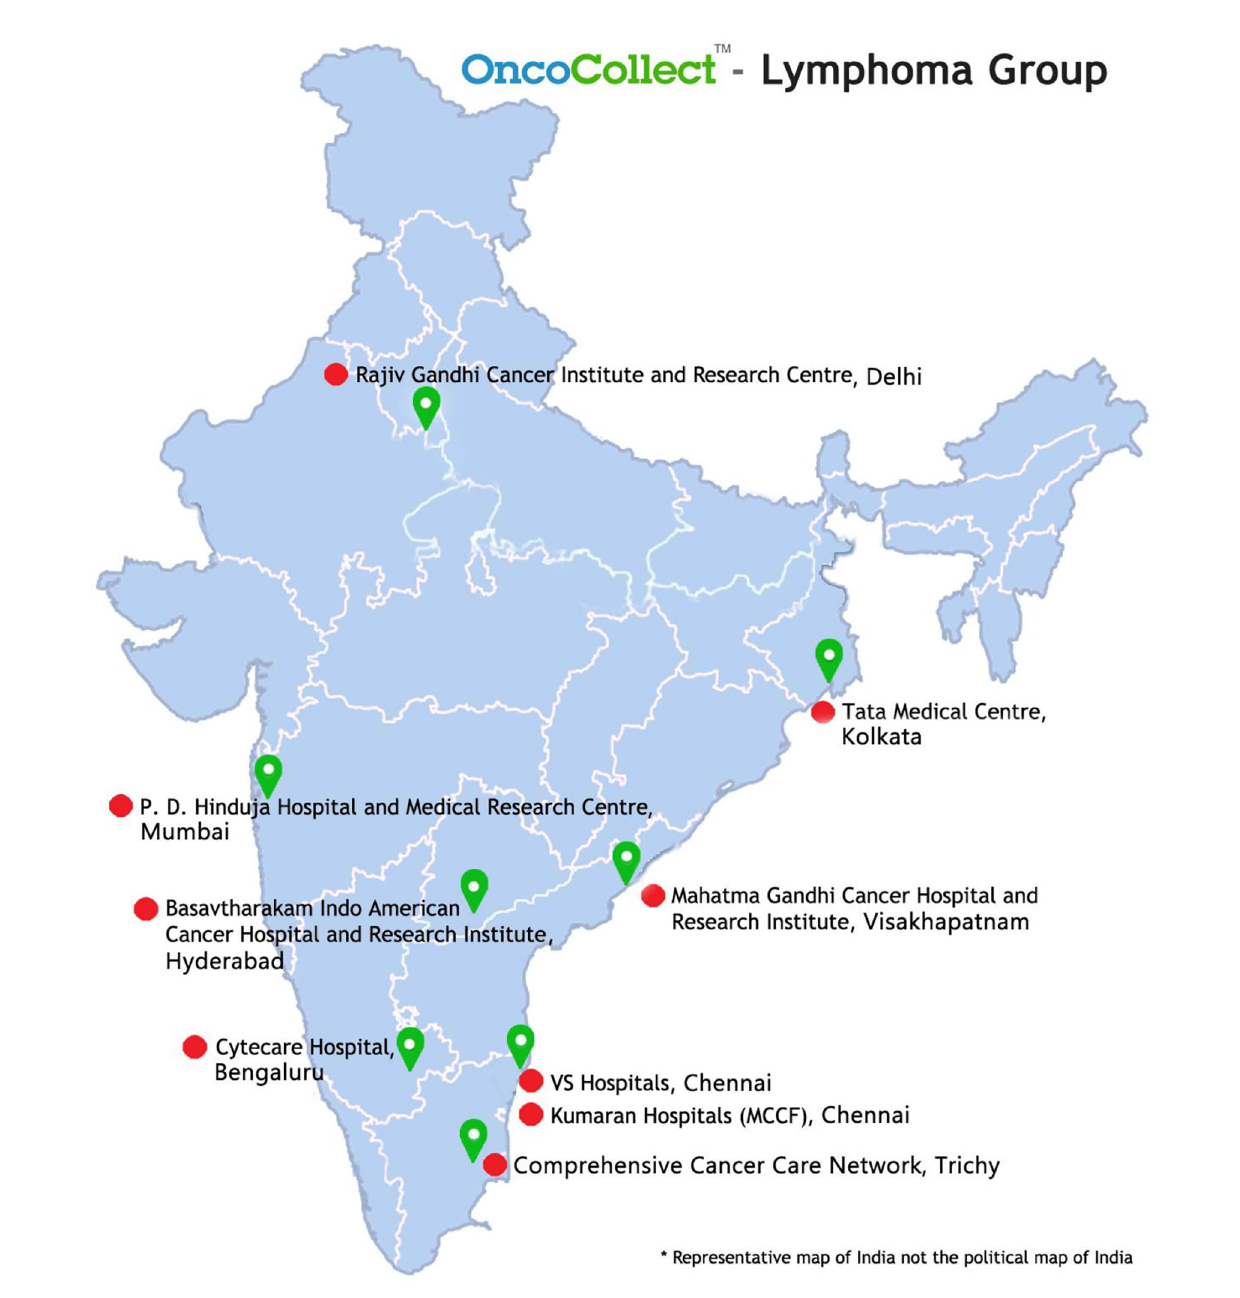
FIGURE 1 | The distribution of institutes participating in the OncoCollect Lymphoma